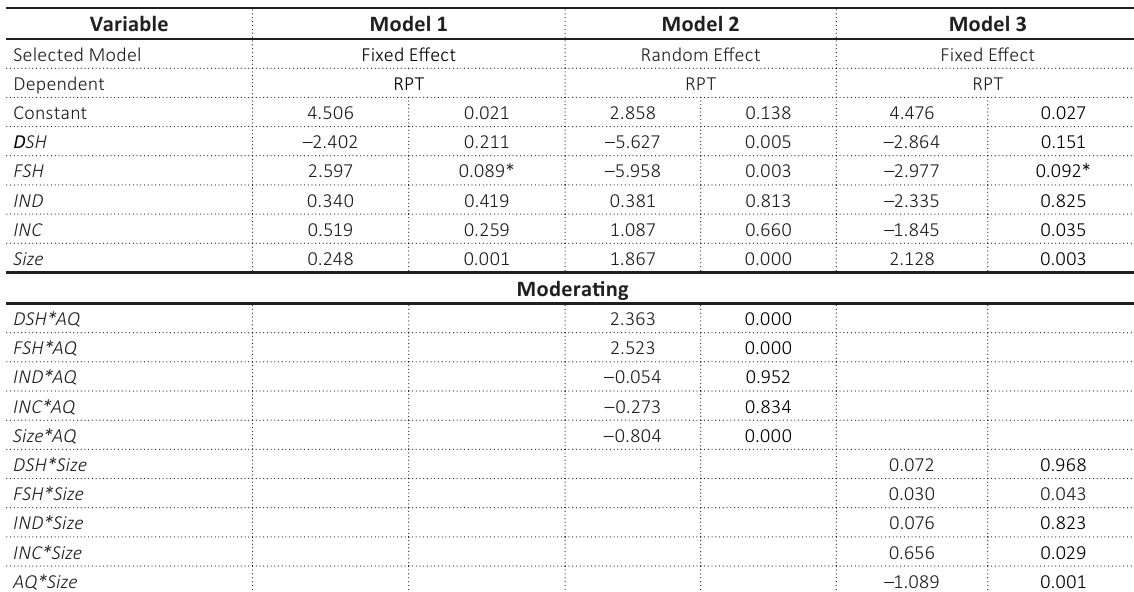
Table 5. Panel regression analysis